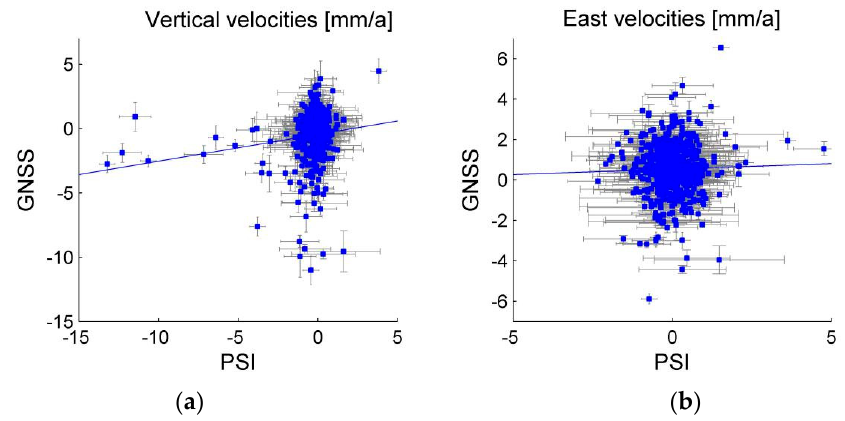
Figure 4. Comparison of the GNSS and SAR velocity components (vertical— a , East— b ) calculated for each of 621 GNSS sites. The SAR velocities were calculated by applying exponential inverse distance weighting [41,42] to a cloud of points 1000 m from each GNSS site. The blue lines represent the Pearson correlation between the two techniques. The Pearson correlation coefficient is 0.19 for the vertical component (top-left) and 0.028 for the east component (top-right).